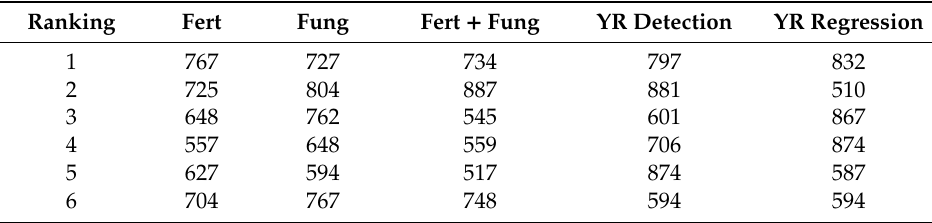
Table 3. The six most important bands for selected plot traits at the UAV scale and ranking of the wavebands (in nm) for the importance of feature selection, beginning with the highest. Selected traits: fertilizer (Fert), fungicide (Fung), fungicide + fertilizer (Fert + Fung), yellow rust (YR) detection, yellow rust